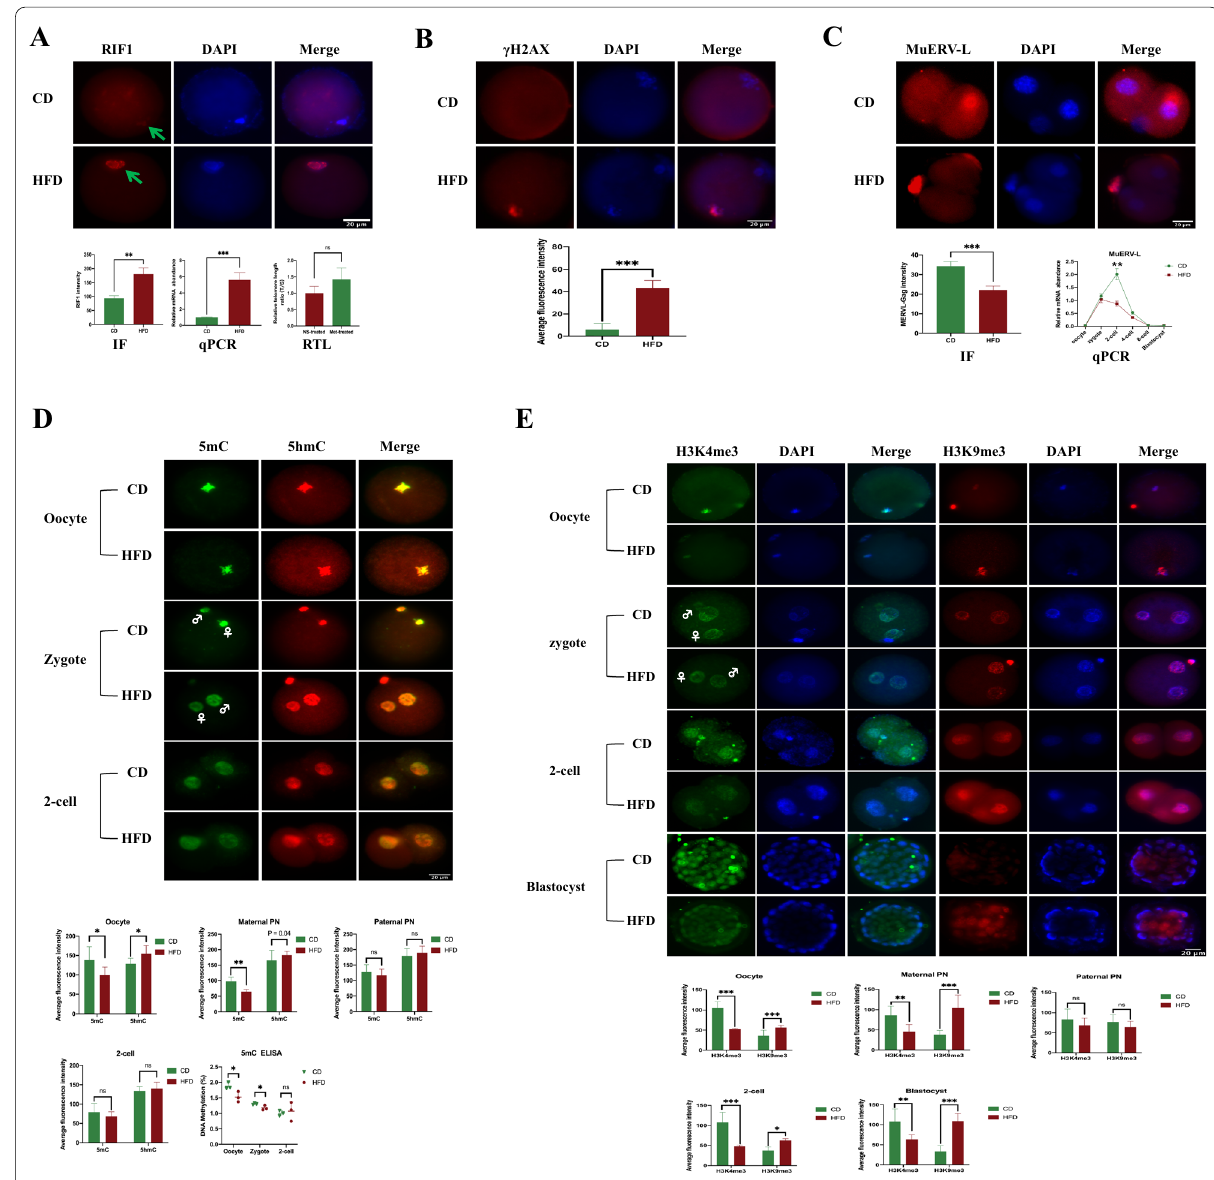
Fig. 3 The effects of HFD on RIF1 and epigenetic modification changes in oocytes and preimplantation embryos. A The expression of RIF1 in oocytes of the HFD and CD groups. Top: representative immunofluorescence (IF) images. Arrowheads indicate the expression of RIF1 located in the nucleus. The bar chart in the middle of bottom: qPCR results of RIF1. The bar chart in the lower right corner: qPCR results of the relative telomere length (RTL). B Images of γ-H2AX staining in oocytes of the HFD and CD groups. Bottom: The statistical results are shown. C The expression of MuERV-L gag between the HFD and CD groups. Top: Representative IF images in 2-cell embryos. Since MuERV-L gag could hardly be detected at the other embryonic development stages, only images of 2-cell embryos are presented. Bottom: Statistical results from IF and qPCR. D IF images of 5mC and 5hmC enrichment during ZGA between the HFD and CD groups. The statistical diagrams and the ELISA results of 5mC are shown at the bottom. E IF images of H3K4me3 and H3K9me3 enrichment from oocytes to blastocysts between the HFD and CD groups. The statistical results are shown at the bottom. Throughout, n 20 in each group for IF analysis, and n 3 in each group for qPCR analysis. Data are presented = = as means SD. P values are calculated by Student’s t test. * p < 0.05, ** p < 0.01, *** p < 0.001. ns indicates not significant. Scale bars are shown in the ± lower right corner of the captures. HFD high-fat diet, CD control diet. ♀ represents maternal pronuclear (PN). ♂ represents paternal